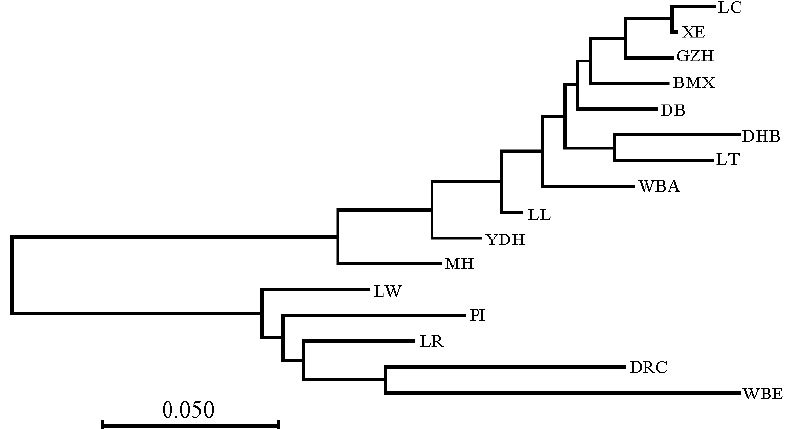
Figure 2. The neighbor-joining tree based on Nei’s genetic distance 1 . 1 DR = Duroc, LW = Large White, LR = Landrace, PI = Pietrain, WBE = European wild boar, WBA = Asian wild boar, BMX = Bamaxiang, DB = Debao, DHB = Dahuabai, GZH = Guizhonghua, LC = Luchuan, LL = Longlin, LT = Lantang, MH = Meihua, XE = Guangdongxiaohua, YDH = Yuedonghei.